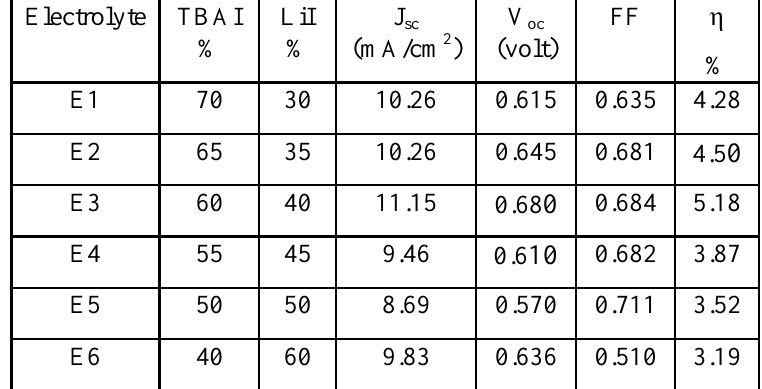
Table 3: Photovoltaic Parameters of the fabricated cells contain six different polymer